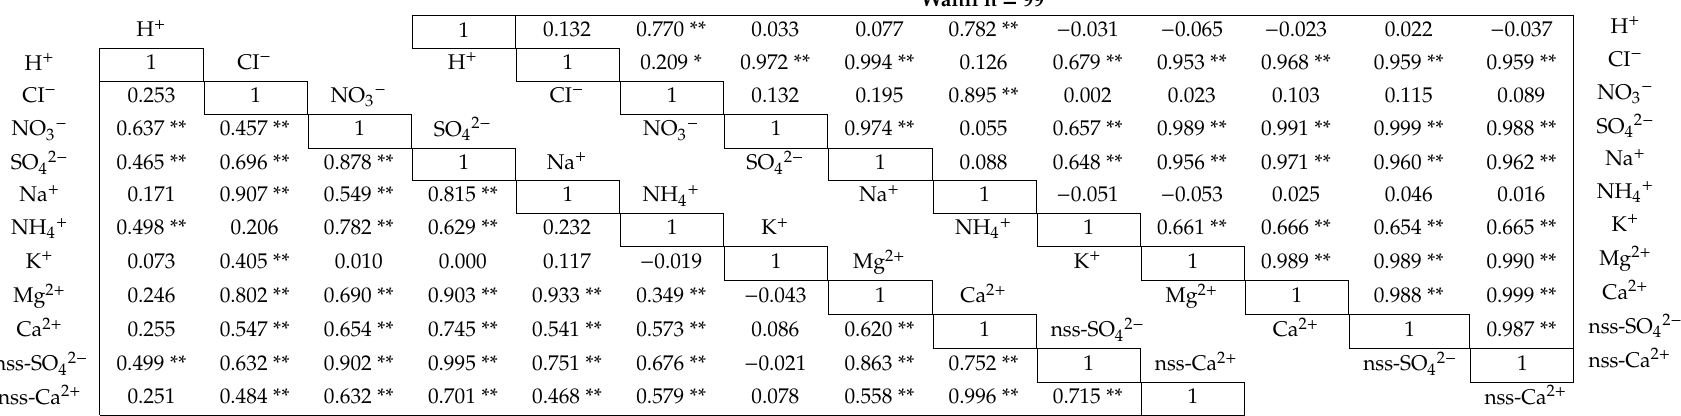
Table 5. Pearson’s correlation coe ffi cient for ionic